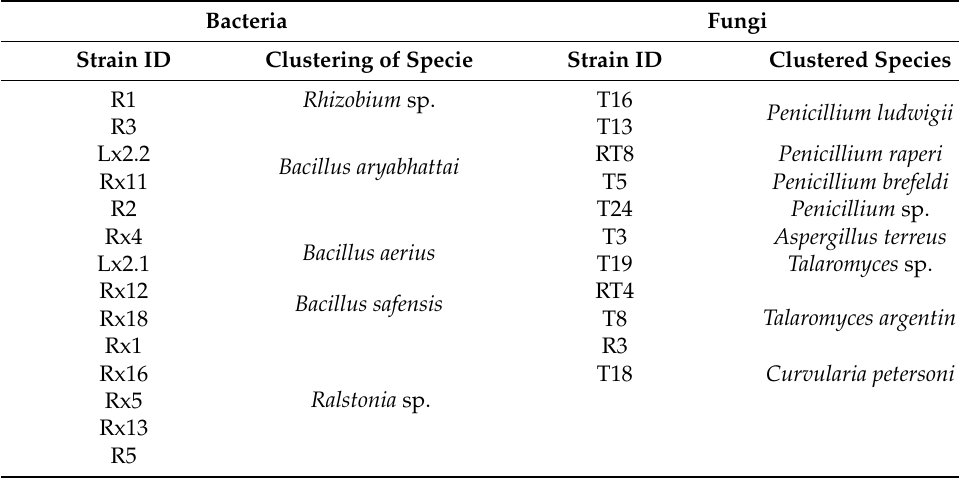
Table 3. Endophytic strains of fungi and bacteria isolated in this study. Bacteria